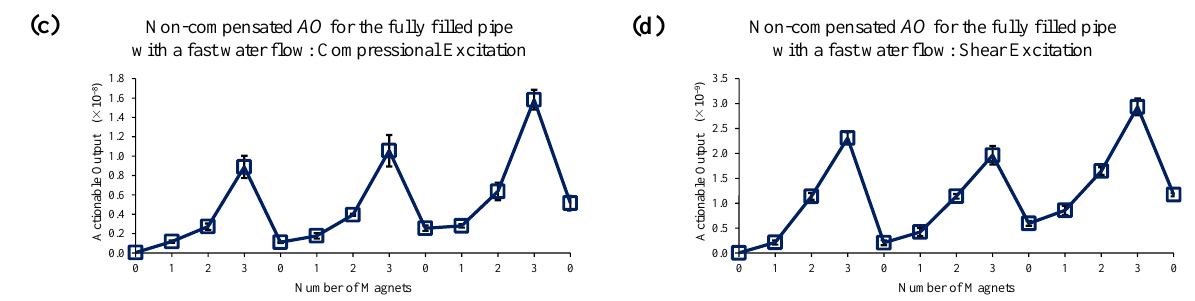
Figure 17. Changes in AO under fast water-flow conditions with the different number of magnet perturbations for the half-filled pipe with ( a ) compressional and ( b ) shear excitations; and the fully filled pipe with ( c ) compressional and ( d ) shear excitations. No EOC compensation method is applied.